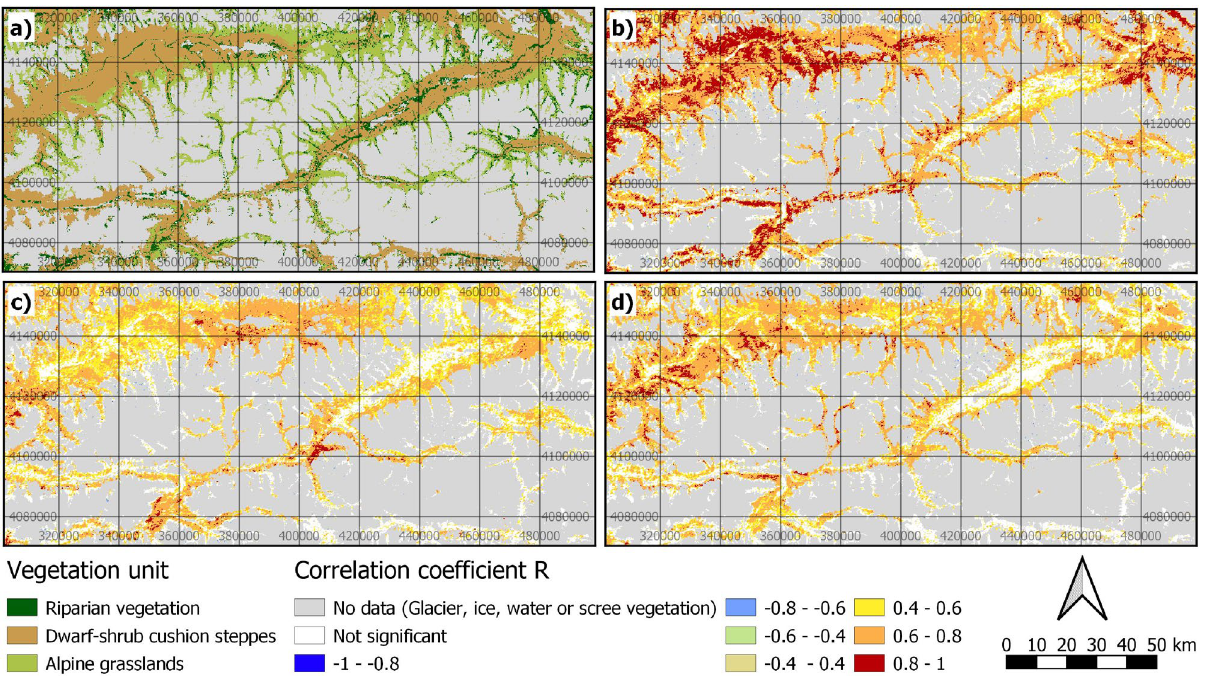
Figure 3. Vegetation units ( a ), significant Pearson’s correlation of MERRA-2 precipitation/Hydrological-year ( b ), ERA5-Land precipitation/Spring–Summer (Mar-Aug) ( c ), and MODIS-NDSI/Spring (Mar-May) ( d ) in the Wakhan region (projection: UTM zone 43 N). Created using QGIS 3.12 (http://qgis.osgeo .org/) 45 .